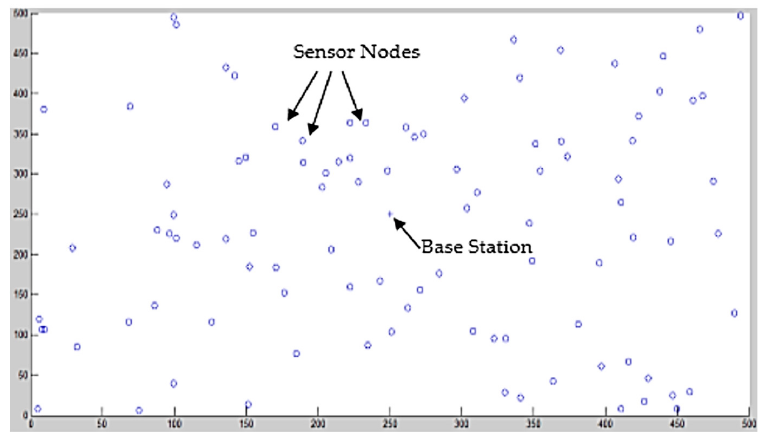
Figure 4. Random deployment of sensor nodes in 500 × 500 m 2 area.